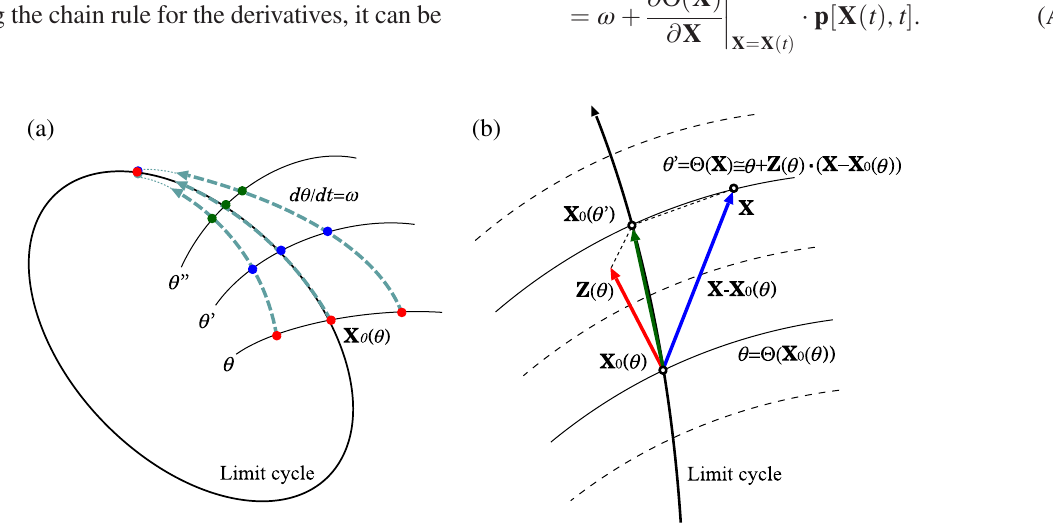
FIG. 5. (a) Isochrons of a limit cycle. The same phase value is assigned to the oscillator states that asymptotically converge to the same state on the limit cycle. (b) Linear approximation of the phase function near the limit